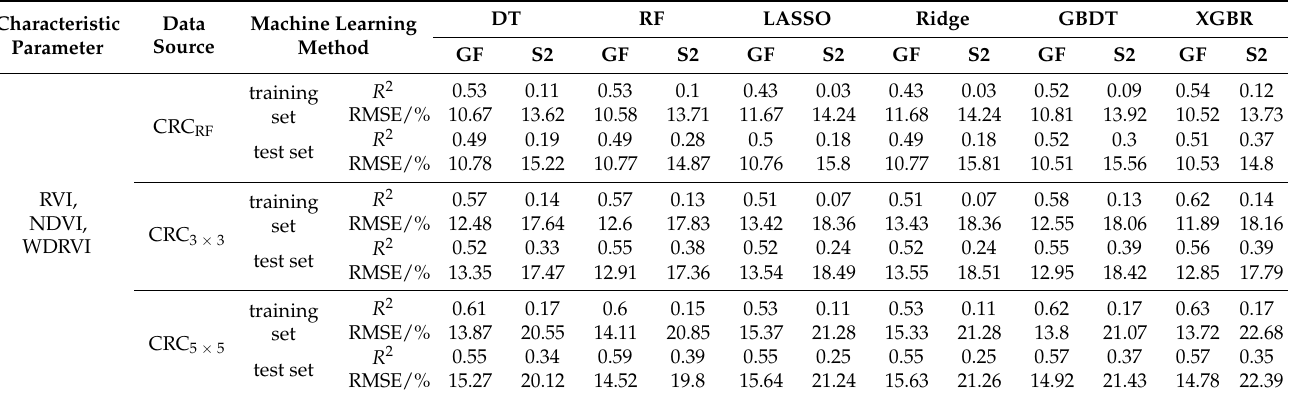
Table 4. Comparison of machine learning regression models for GF-1 and Sentinel-2